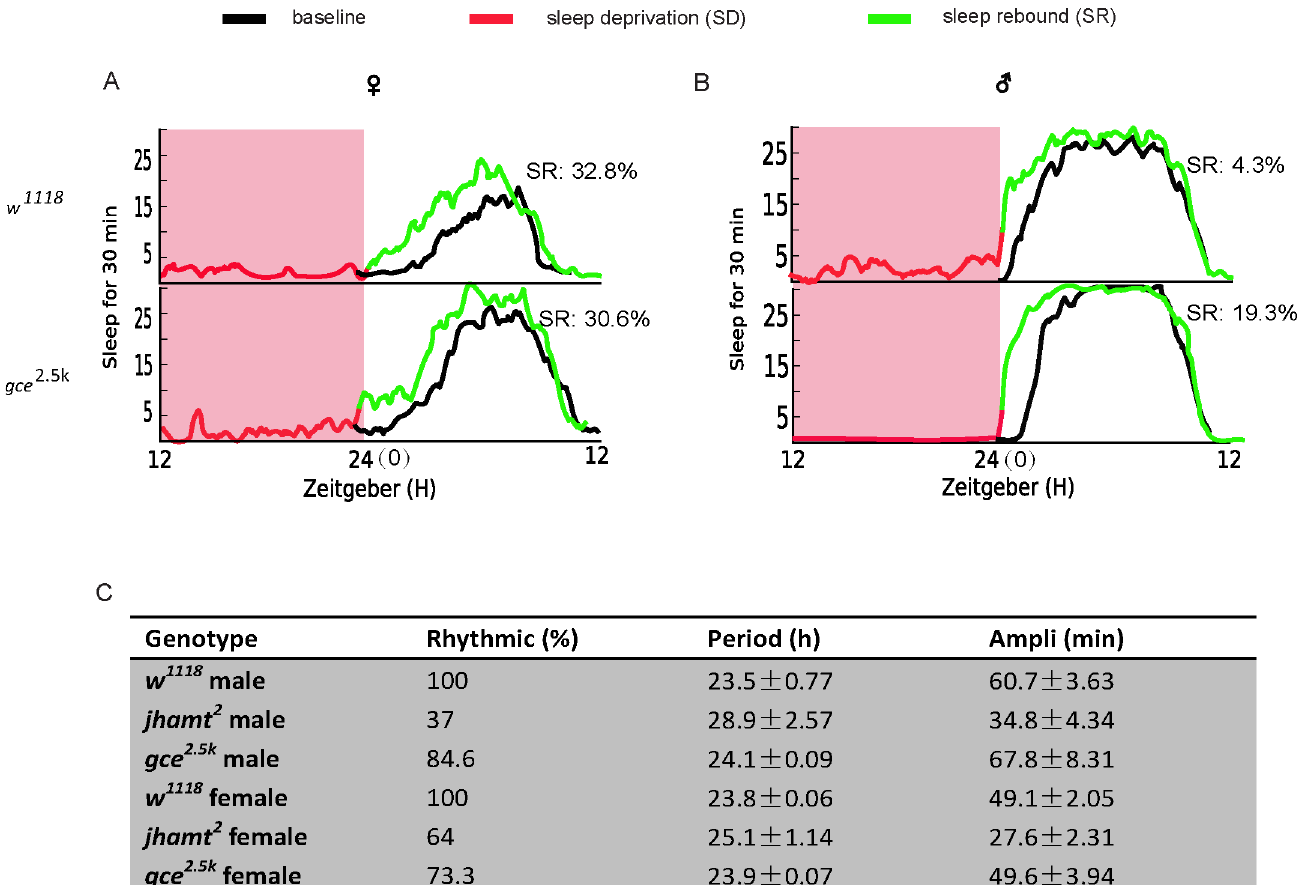
Fig 6. Sleep homeostatic system was completely preserved in gce 2 . 5k flies. (A and B) The w 1118 and gce 2 . 5k flies exhibit sleep rebound after sleep deprivation. The black line represents sleep baseline. The red line (ZT 12 -ZT 24) represents sleep deprivation. The green line (ZT0-ZT12) represents sleep rebound. (C) Circadian phenotypes of w 1118 , jhamt 2 and gce 2 . 5k . Data represent mean±SEM(n = 32–96).